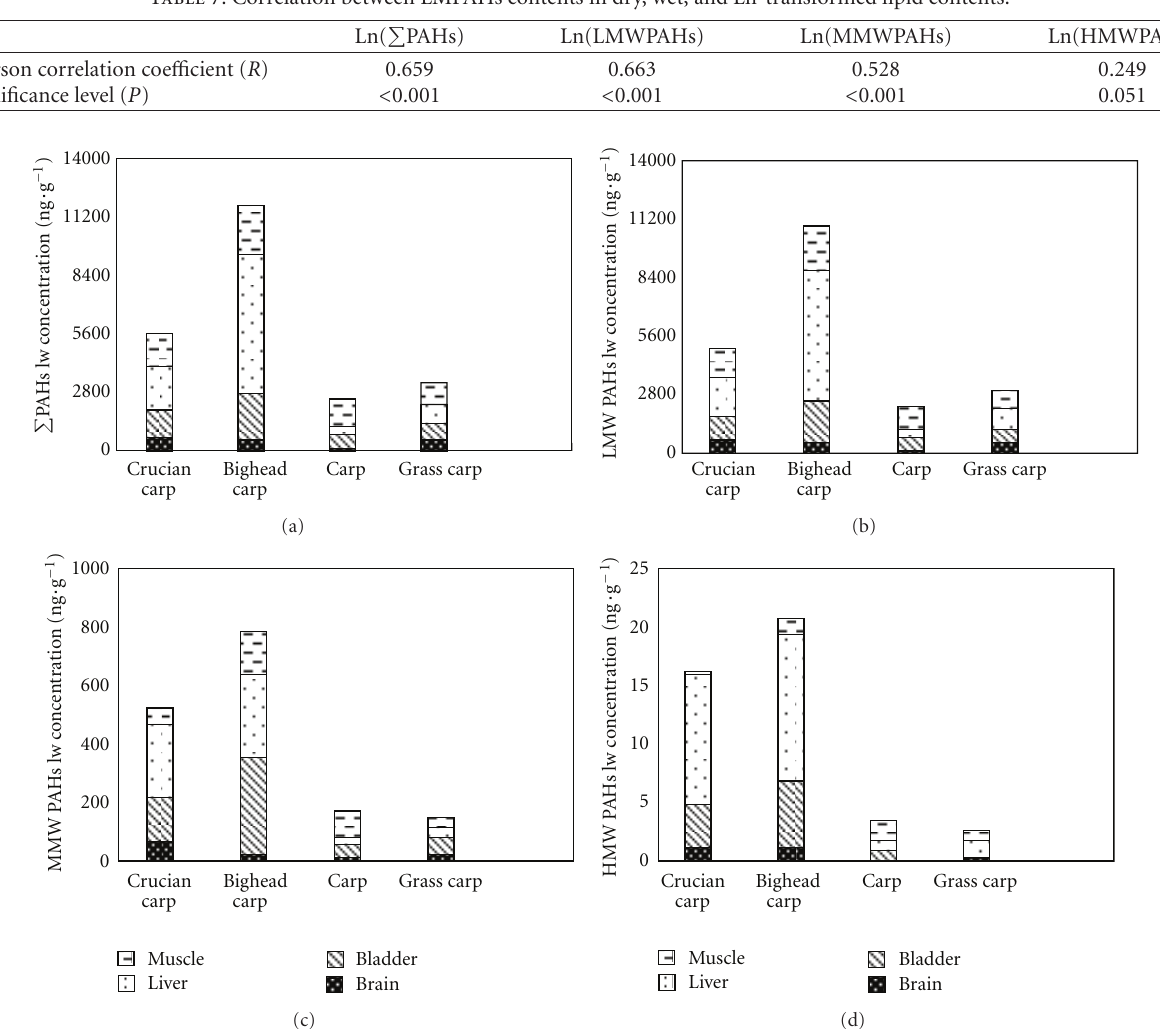
Table 7: Correlation between LMPAHs contents in dry, wet, and Ln-transformed lipid contents.